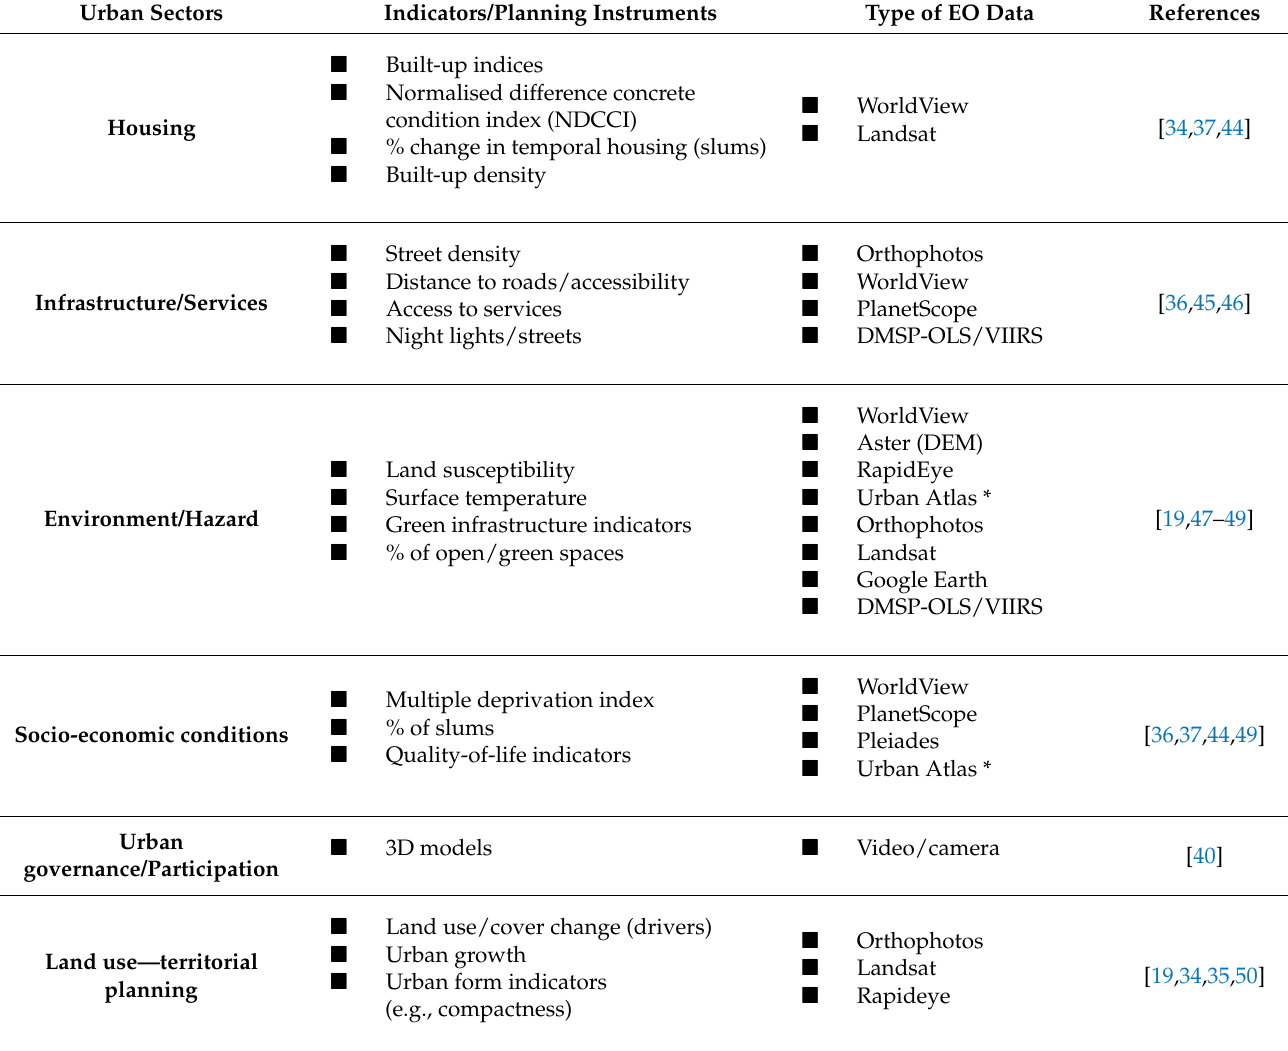
Table 1. Urban planning indicators supported by Earth observation (EO) data within publications of the special issue (* based on EO